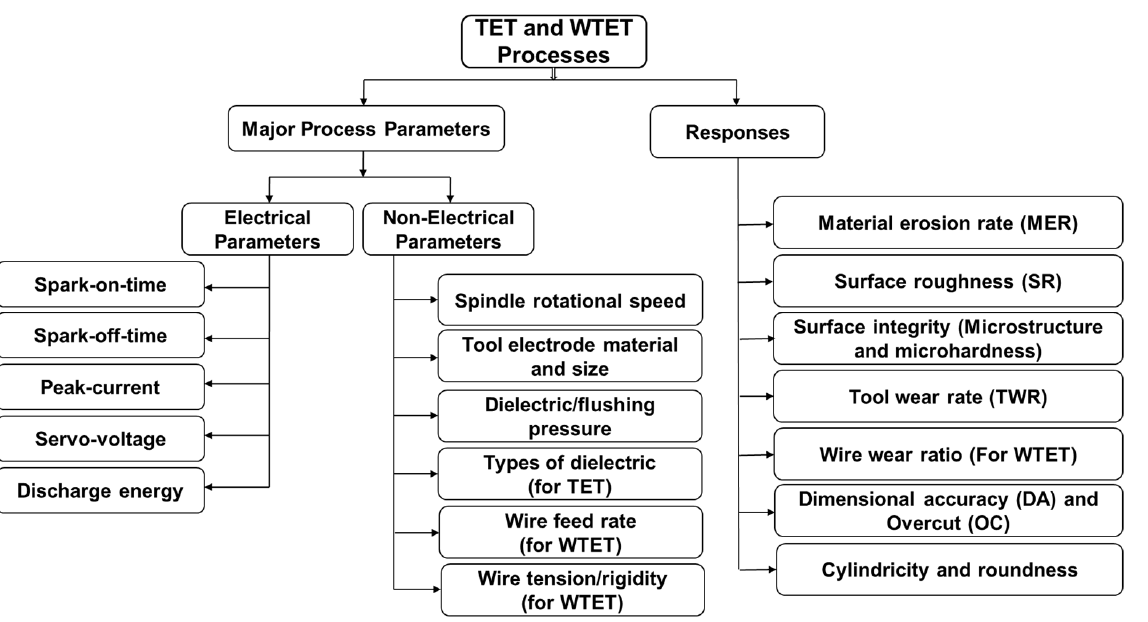
Figure 3. The process parameters and responses of thermoelectric-erosion based turning processes. Spark-on-time (S on ) indicates the time duration in microseconds during which sparks are generated between the inter-electrode gap (IEG). Spark-off-time (S off ) represents the time duration in microseconds between happenings of two consecutive sparks. Material removal takes place during spark-on-time. Peak current (P C ) is the extreme value of the current passing through the electrodes for the given pulse and its value is displayed directly on an ammeter equipped with a machine during the turning process. Servo voltage is the value of the voltage during the formation of the discharge channel between the IEG and the dielectric breaks down in the IEG. The discharge energy is the amount of heat released between the IEG. The discharge energy can be determined from the electrical parameters of TET and WTET. The higher values of the discharge energy result in a higher material erosion rate (MER). Flushing pressure (kg/cm 2 ) is the pressure of the dielectric through IEG to flush away the eroded particles from there. Spindle rotational speed (SRS) is the rotational speed of the spindle per minute (RPM). The chuck or collet is attached to the spindle which holds the cylindrical workpiece. It is the most important parameter of TET and WTET processes and its higher values are desirable for straight and taper turning to achieve better surface quality and productivity. Wire feed rate is the rate at which the fresh wire continuously moves through the wire guides and the IEG for sparking. Its higher value is preferable for stable machining without wire breakage. Wire breakage increases the machining time and deteriorates the surface quality of the components and parts. Wire tension indicates the rigidity of wire between the wire guides. A high wire tension is desirable for stable machining and to avoid wire vibration. Wire vibration is responsible for short-circuiting and poor dimensional accuracy. Dielectric plays an important role